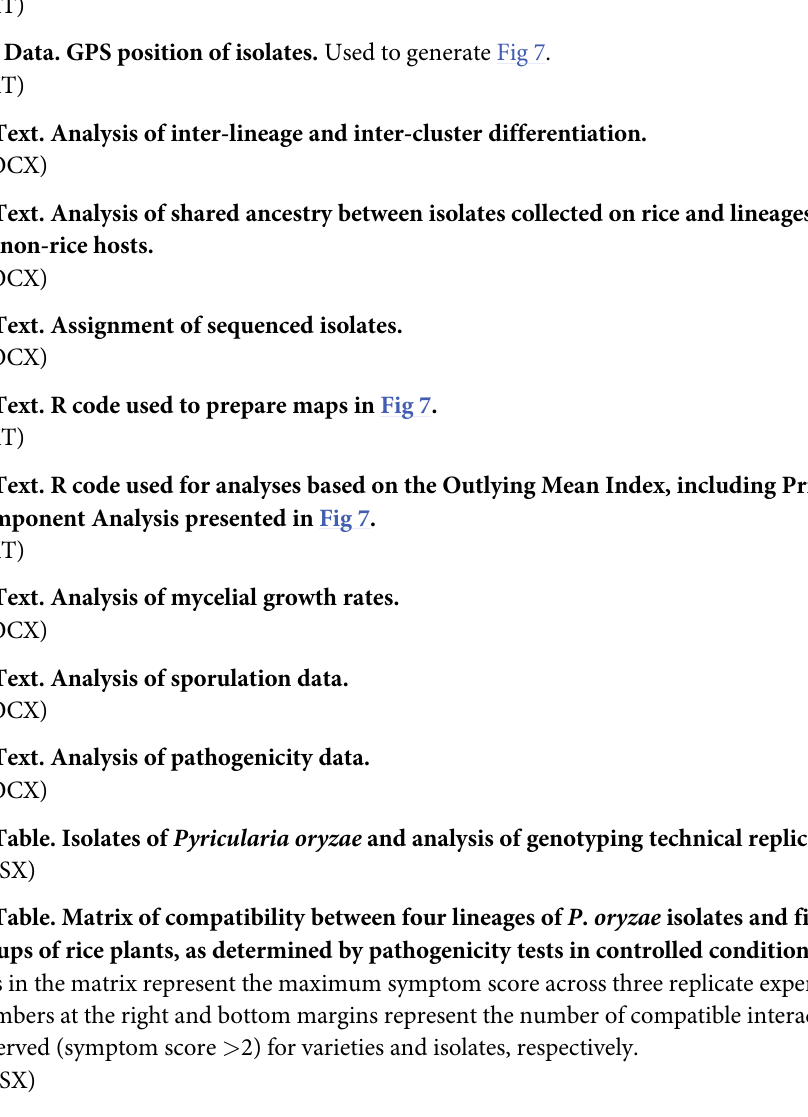
S4 Table. Non-synonymous and synonymous polymorphism in four lineages of P . oryzae . For each lineage, only orthogroups with sample size > = 4 were included in calculations. Line- age: lineage of origin of genomes used in calculations for each orthogroup.